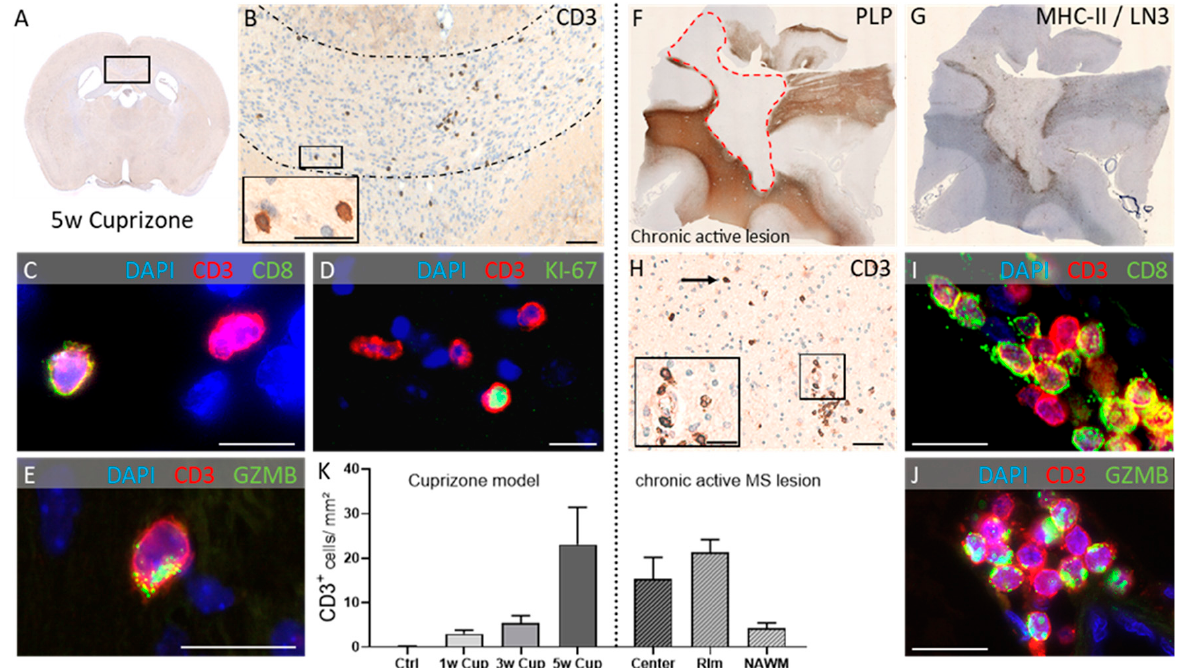
Figure 3. Peripheral immune cell recruitment in the cuprizone model (left) and progressive MS lesions (right). ( A ) Overview. ( B ) Representative image demonstrating CD3 + lymphocytes in the corpus callosum of cuprizone-intoxicated mice (five weeks). Around 60 % of the recruited lymphocytes are CD8 + cytotoxic lymphocytes. ( C ) ~20–30 % are proliferating (Ki67 + ; ( D )) and express cytotoxic granules (GZMB + ; ( E )). ( F ) Overview of a representative chronic active multiple sclerosis (MS) lesion. The red dotted line demarcates the lesion in an anti-myelin proteolipid protein (PLP)-stained section. ( G ) A consecutive anti-major histocompatibility complex class II (MHC-II)/LN3-stained section shows the lesion rim. ( H ) High- power view of the same lesion demonstrates the distribution of CD3 + lymphocytes. Lymphocytes display a CD8+ phenotype ( I ) and express cytotoxic granules (GZMB + ; ( J )). ( K ) Comparative densities of CD3 + lymphocytes during the course of cuprizone-induced demyelination and in the center, rim and normally appearing white matter (NAWM) areas of chronic active MS lesions. PLP: Proteolipid-Protein 1; DAPI: 4 (cid:48) ,6-Diamidino-2-phenylindol; GZMB: Granzyme B. Scale bars: ( B ) = 50 µ m, insert ( B ) = 20 µ m, ( C ) = 10 µ m, ( D ) = 15 µ m, ( E ) = 10 µ m, ( H ) = 50 µ m, insert ( H ) = 25 µ m, ( I ) = 10 µ m, ( J ) = 10 µ m. Figure modified, courtesy of John Wiley & Sons, license number: